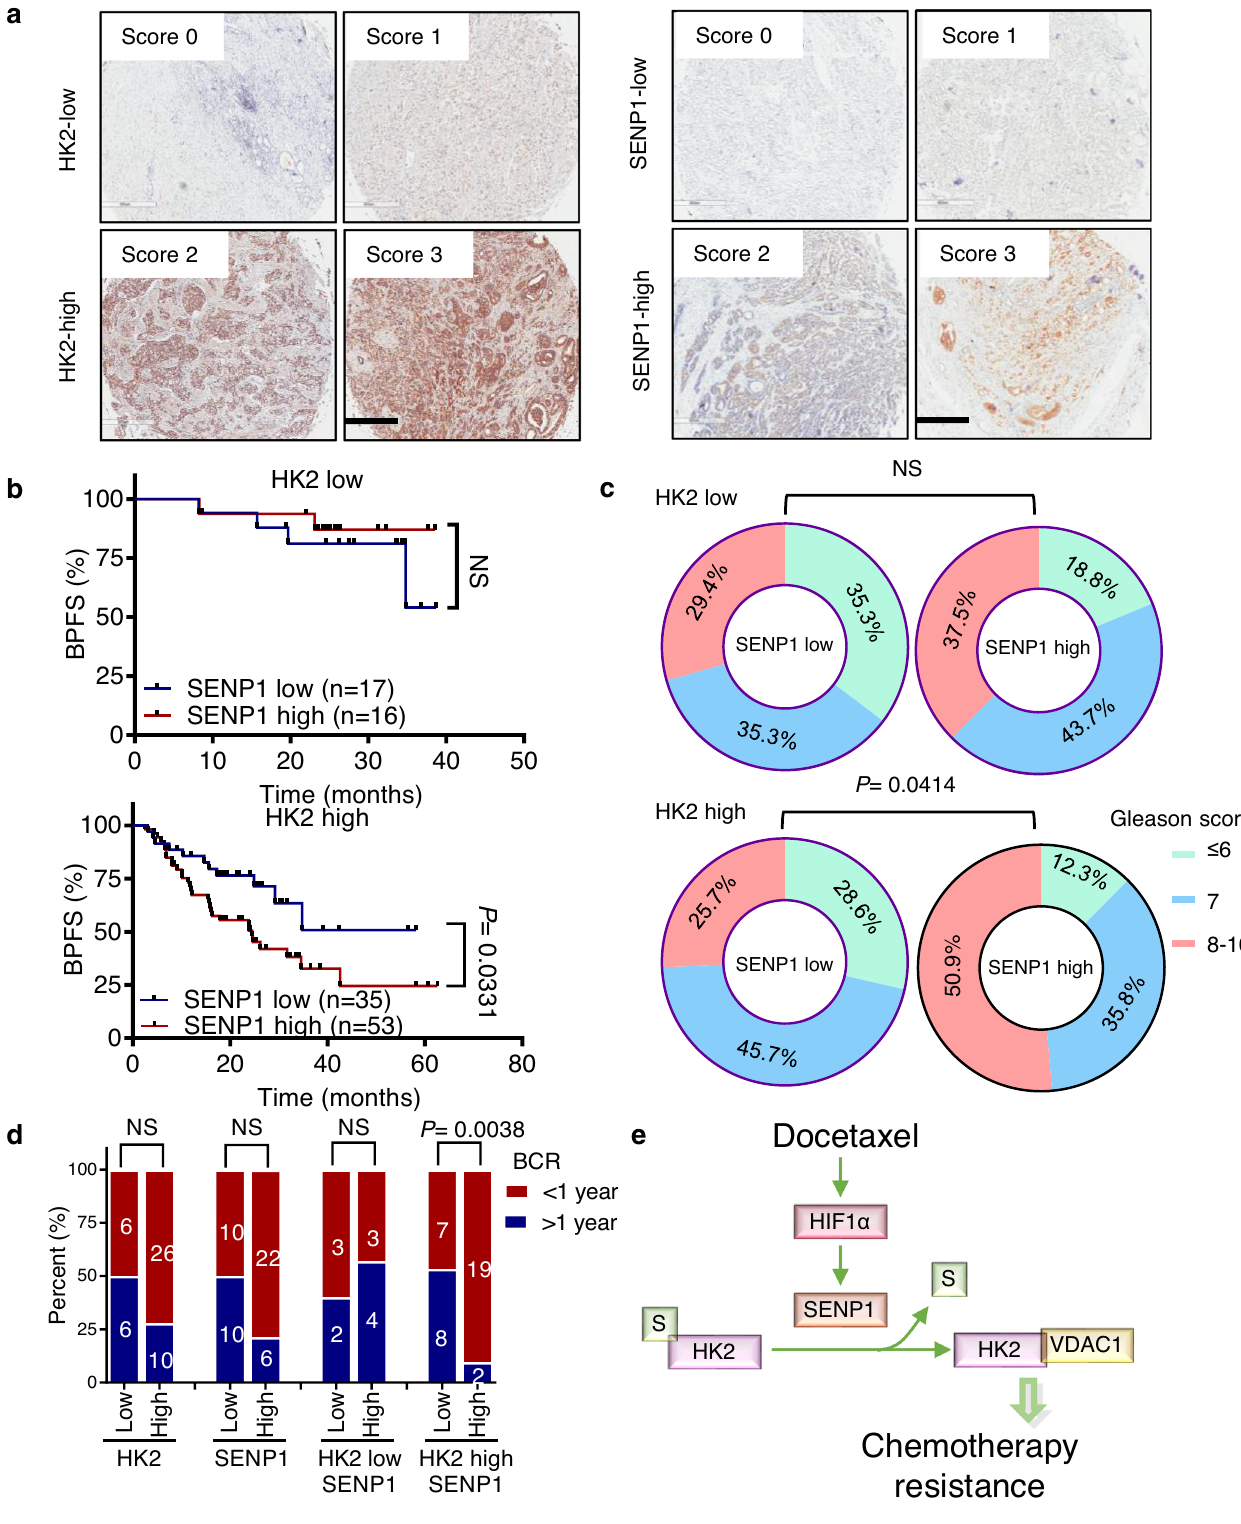
Measurements of glucose consumption and lactate production . A total of 1× 10 6 PC3 cells suspended in 3mL of medium were seeded in 60-mm dishes, and the medium was changed after 12h with no serum RPMI-1640. Cells were incubated for 20 and 8h for measurement of glucose consumption and lactate production, respectively. The culture medium was then collected for measurement of the glucose and lactate concentrations. Glucose levels were determined using a glucose (GO) assay kit (Sigma, GAGO-20). Glucose consumption was de fi ned as